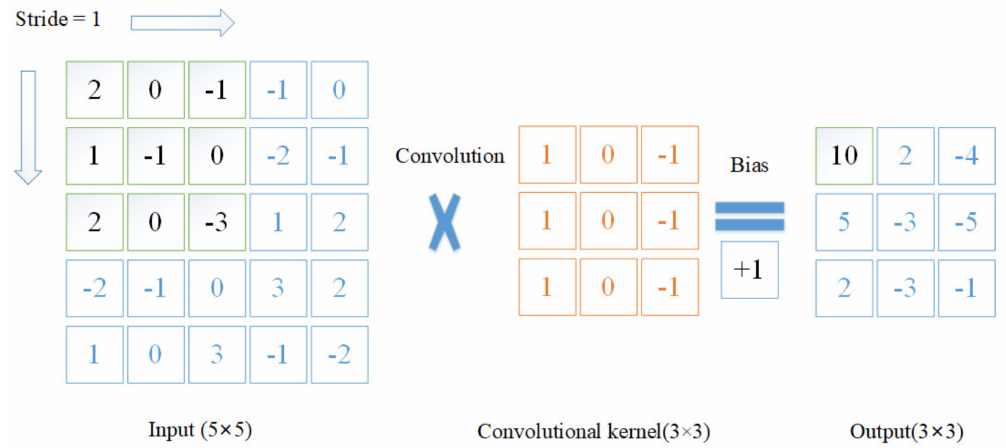
Figure 3. The principle of convolutional